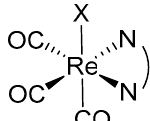
Figure 3. General structure of Re(I) tricarbonyl core with variable X depending on the ligands incorporated to form different Re(I) tricarbonyl complexes with different phototoxic activity on cancer cell lines.